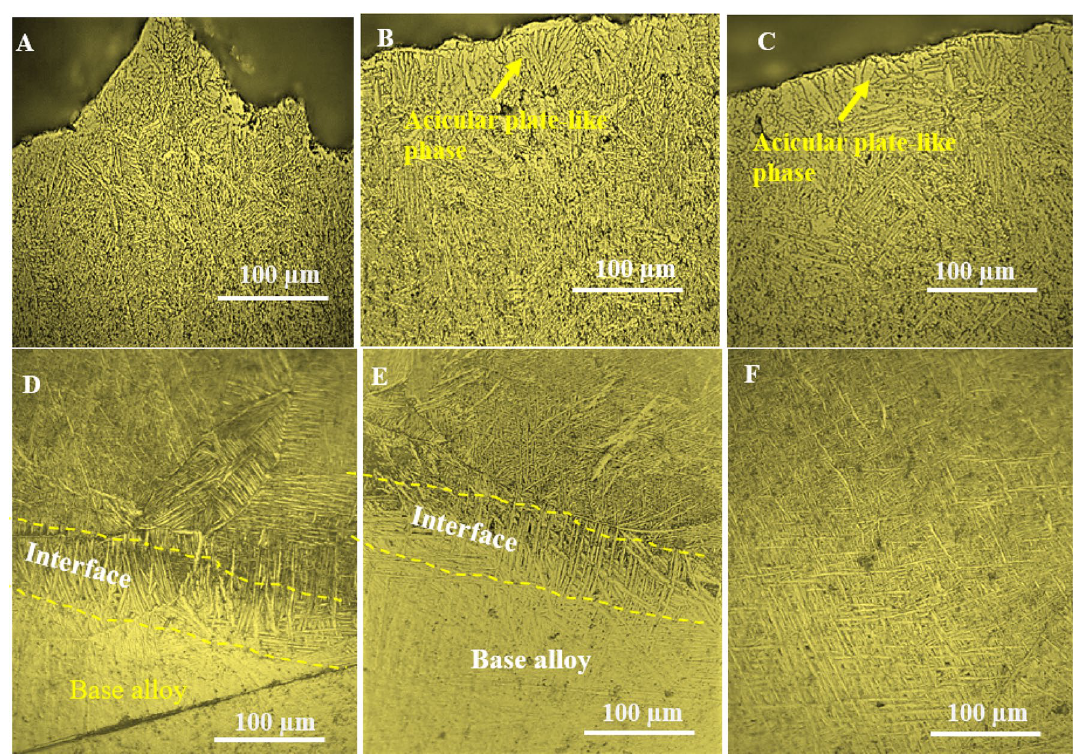
Figure 2. ( A ) Optical microscopic image of the microstructure formed ( A – C ) when 250 nm TiO 2 /40 nm Al 2 O 3 and particles are deposited in the coating. ( D – F ) when 30 nm TiO 2 /40 nm Al 2 O 3 particles are deposited in the